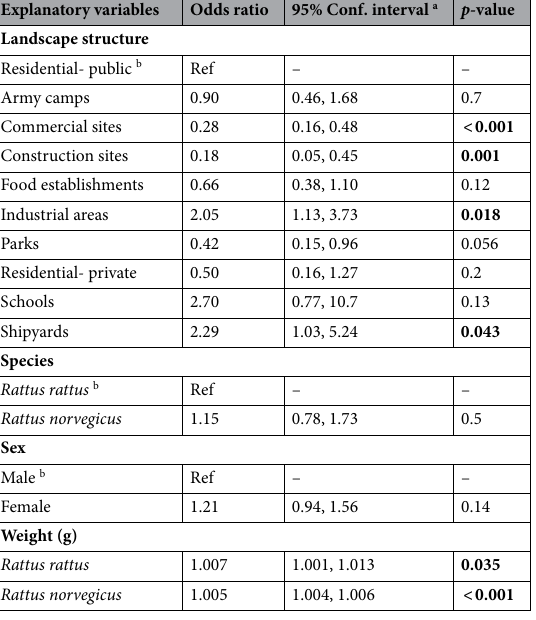
Table 6. Bivariable logistic regression analysis for Rickettsia typhi antibody detection in Rattus rattus and Rattus norvegicus . Significant values ( P < 0.05) are shown in bold. a 95% Confidence Interval. b Reference category.